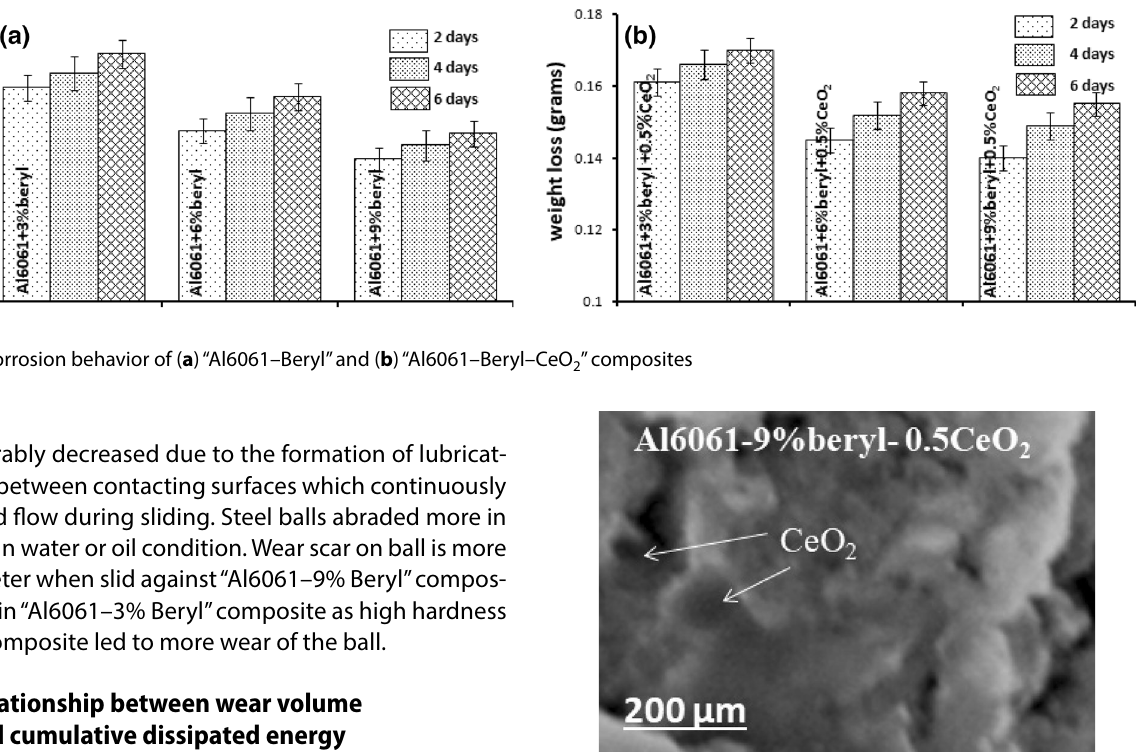
Fig. 11 Linear relationship between wear volume ( V ) and dissipated energy ( E ites against steel in ( a ) air and ( b ) oil